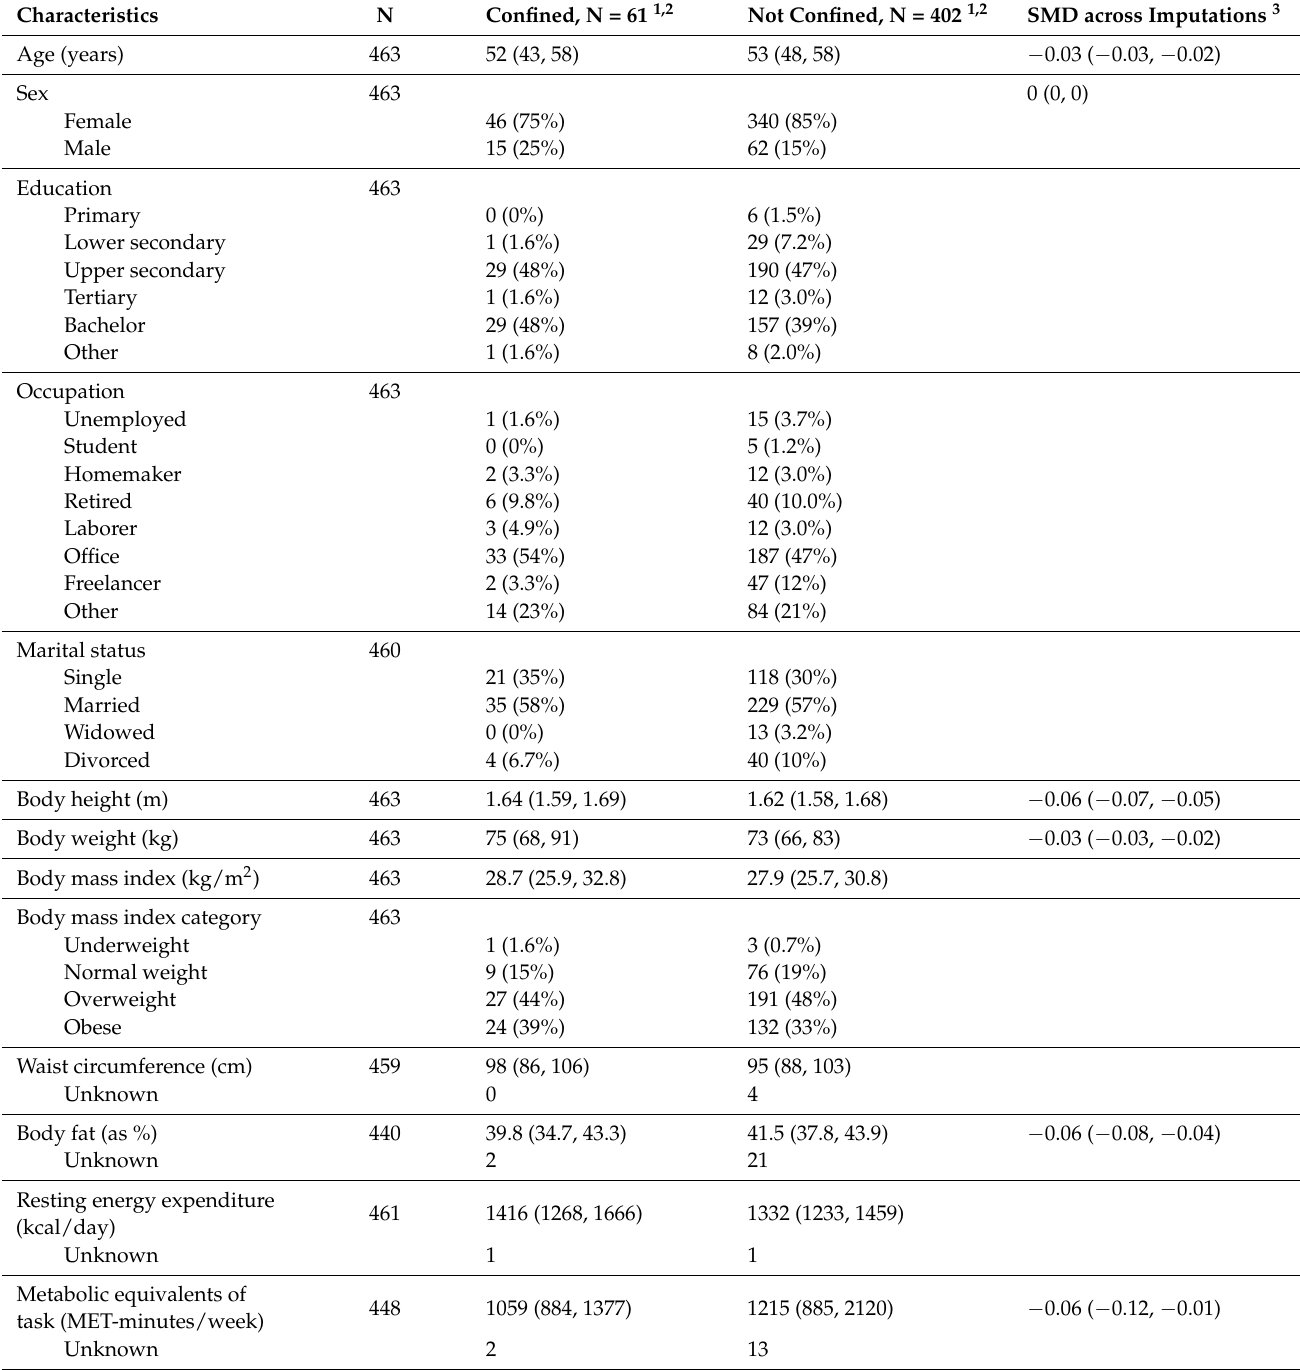
Table 1. Baseline characteristics of matched confined and non-confined group, with covariate